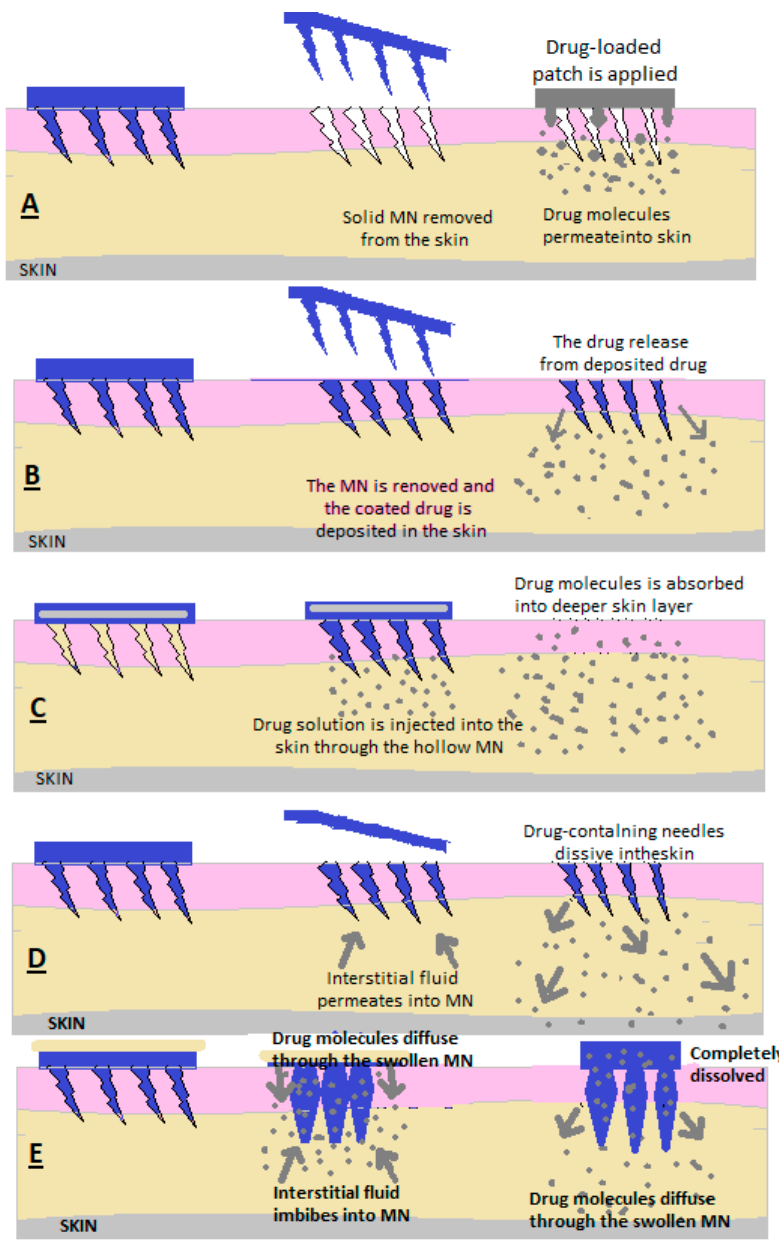
Figure 6. Drug release through ( A ) solid MN, ( B ) covered MN, ( C ) empty MN, ( D ) dissolving MN and ( E ) MN that forms a hydrogel [30].